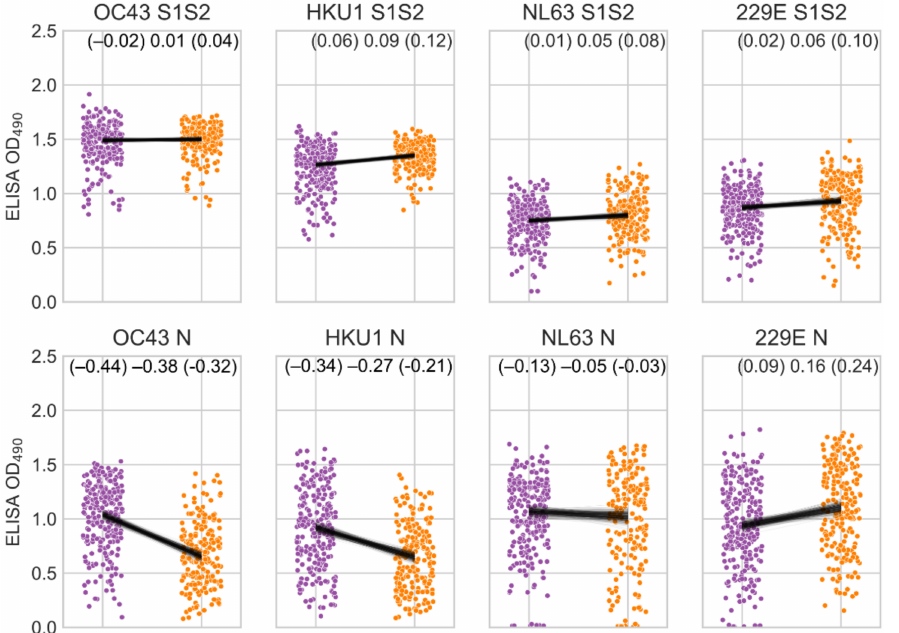
Figure 2. Reactivity of pre-pandemic and SARS-CoV-2 PCR-positive human sera (SARS2+) to HCoV antigens. ELISA OD values for 1:40 diluted serum against HCoV S1S2 and N proteins. Black lines are the posterior distribution of differences in group means inferred from a linear model using Student-T distributed error. The upper and lower boundaries and mean of the 95% highest posterior density interval of difference in group means is shown in the top